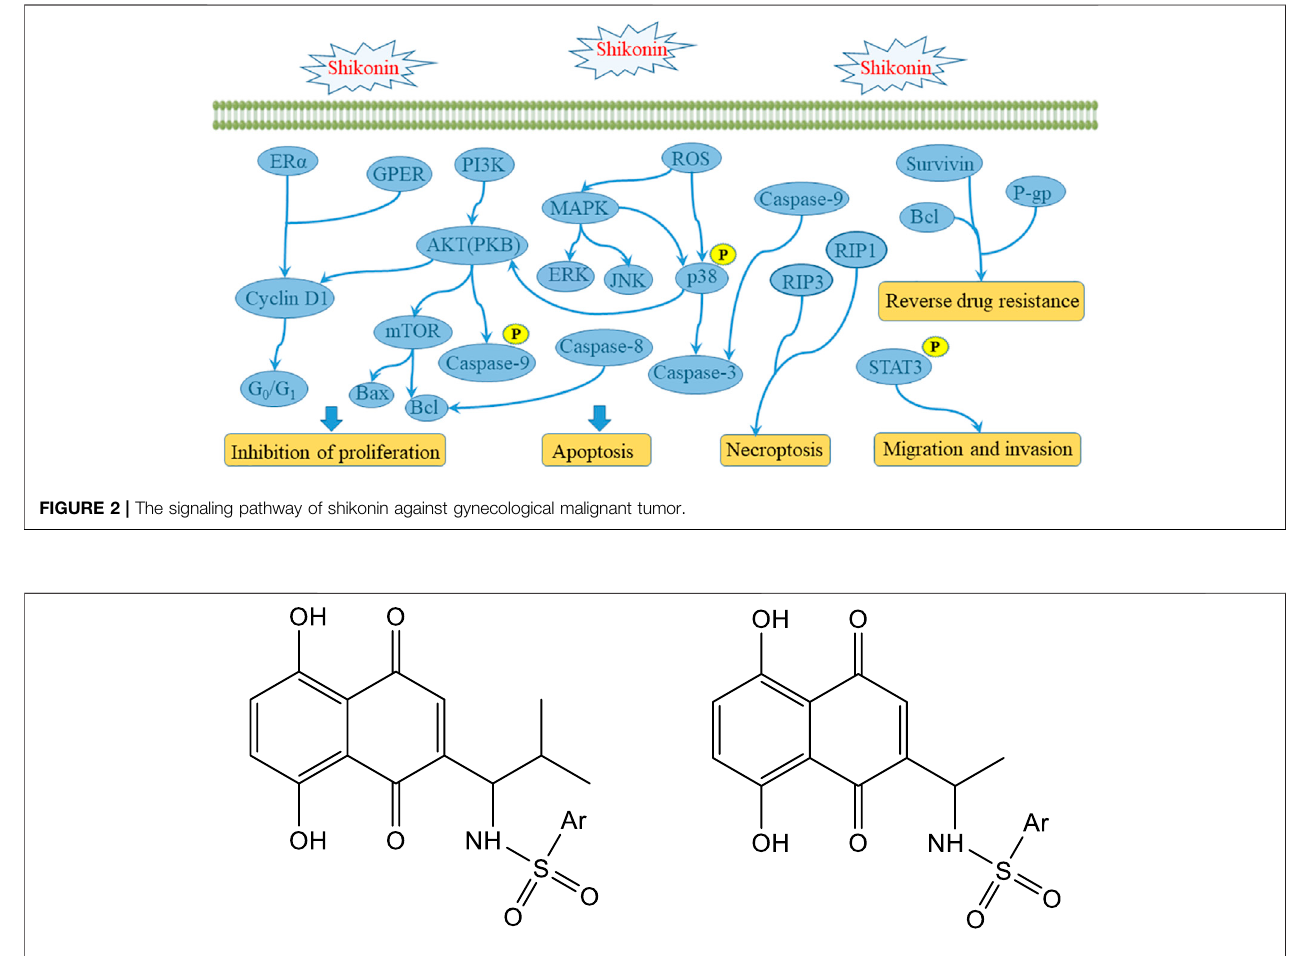
FIGURE 3 | Synthesis of shikonin derivatives with arylsulfonamides side